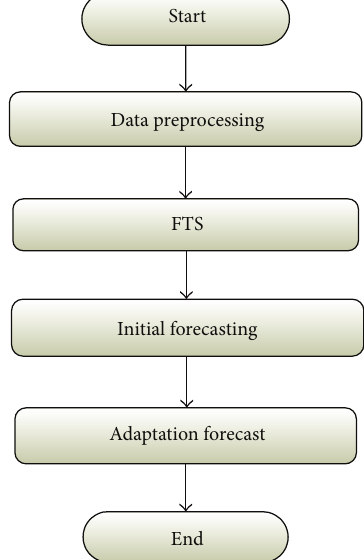
Figure 1: Proposed multilayer